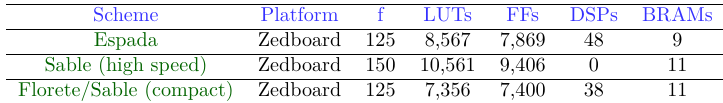
Table 11: Area requirements of the HW/SW implementations in the FPGA, including the processor and interface costs. Scheme Platform f LUTs